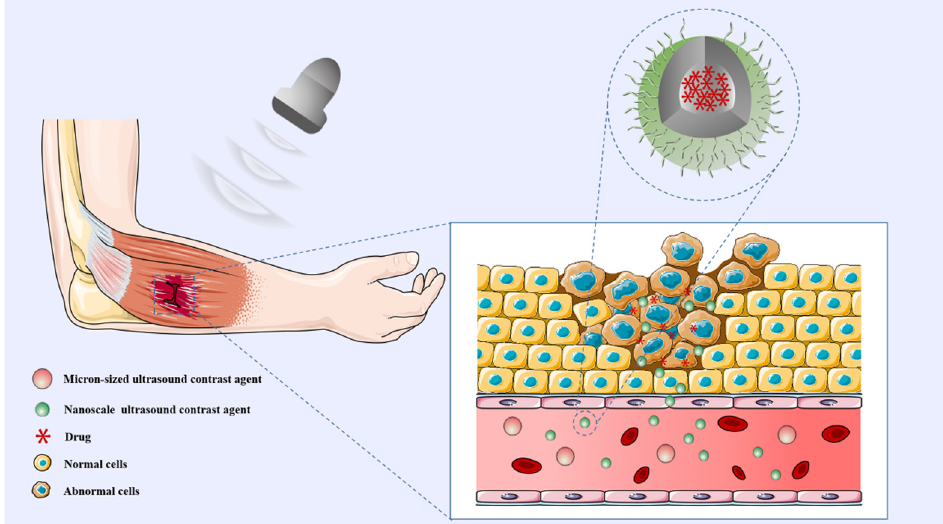
Figure 1. Schematic diagram of the action of nUCAs. The extravascular targeting in the micro- environment of musculoskeletal tissue allows nUCAs to achieve precise targeting and enrichment in damaged or inflamed areas for early diagnosis and assessment. At the same time, it can also serve as a carrier for encapsulated drugs to achieve drug delivery in the target area for rehabilitation, thus realizing the integration of diagnosis and treatment in musculoskeletal